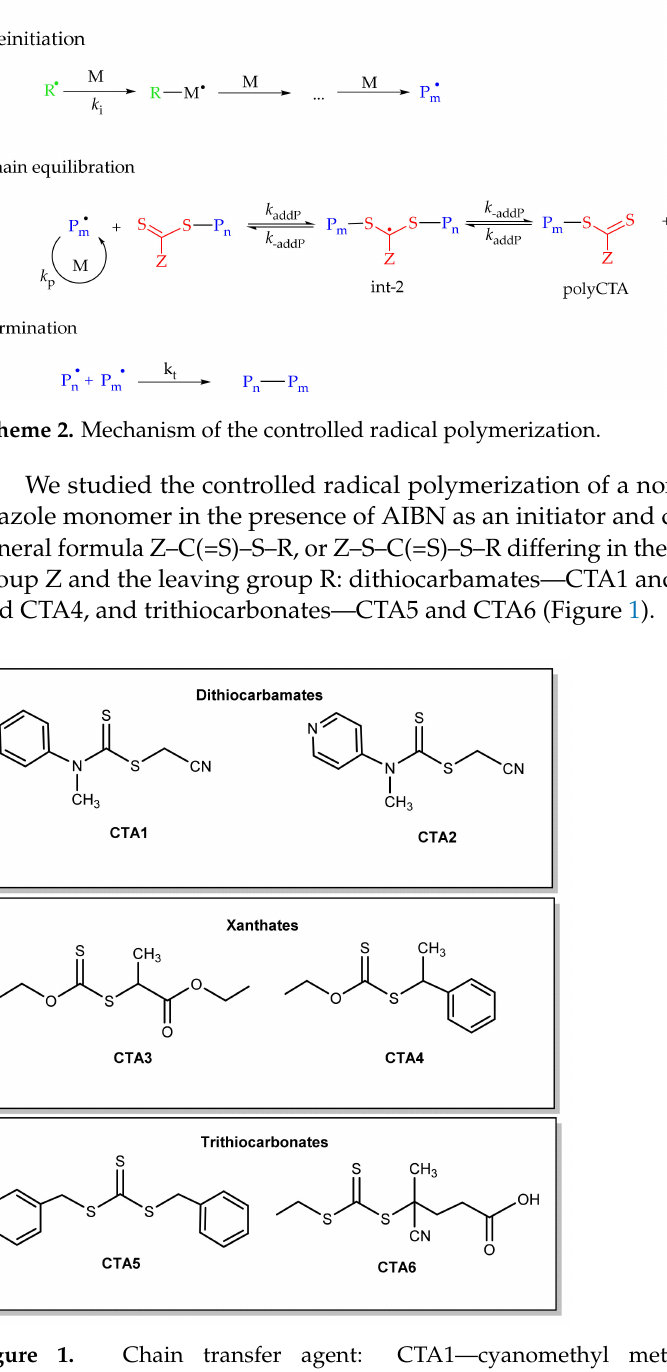
Figure 1. Chain transfer agent: CTA1—cyanomethyl